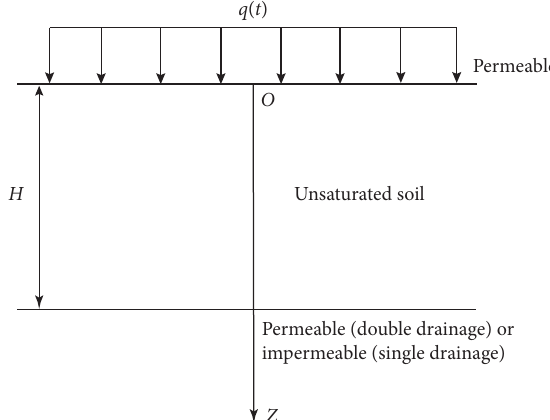
Figure 1: An unsaturated soil layer subjected to time-dependent